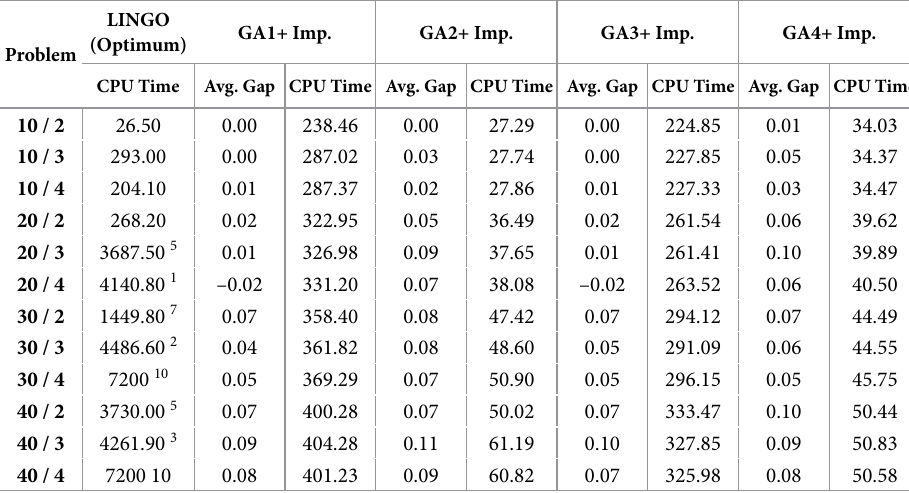
Table 3. Performance of GA as a construction algorithm LINGO GA1+ (Optimum) Problem